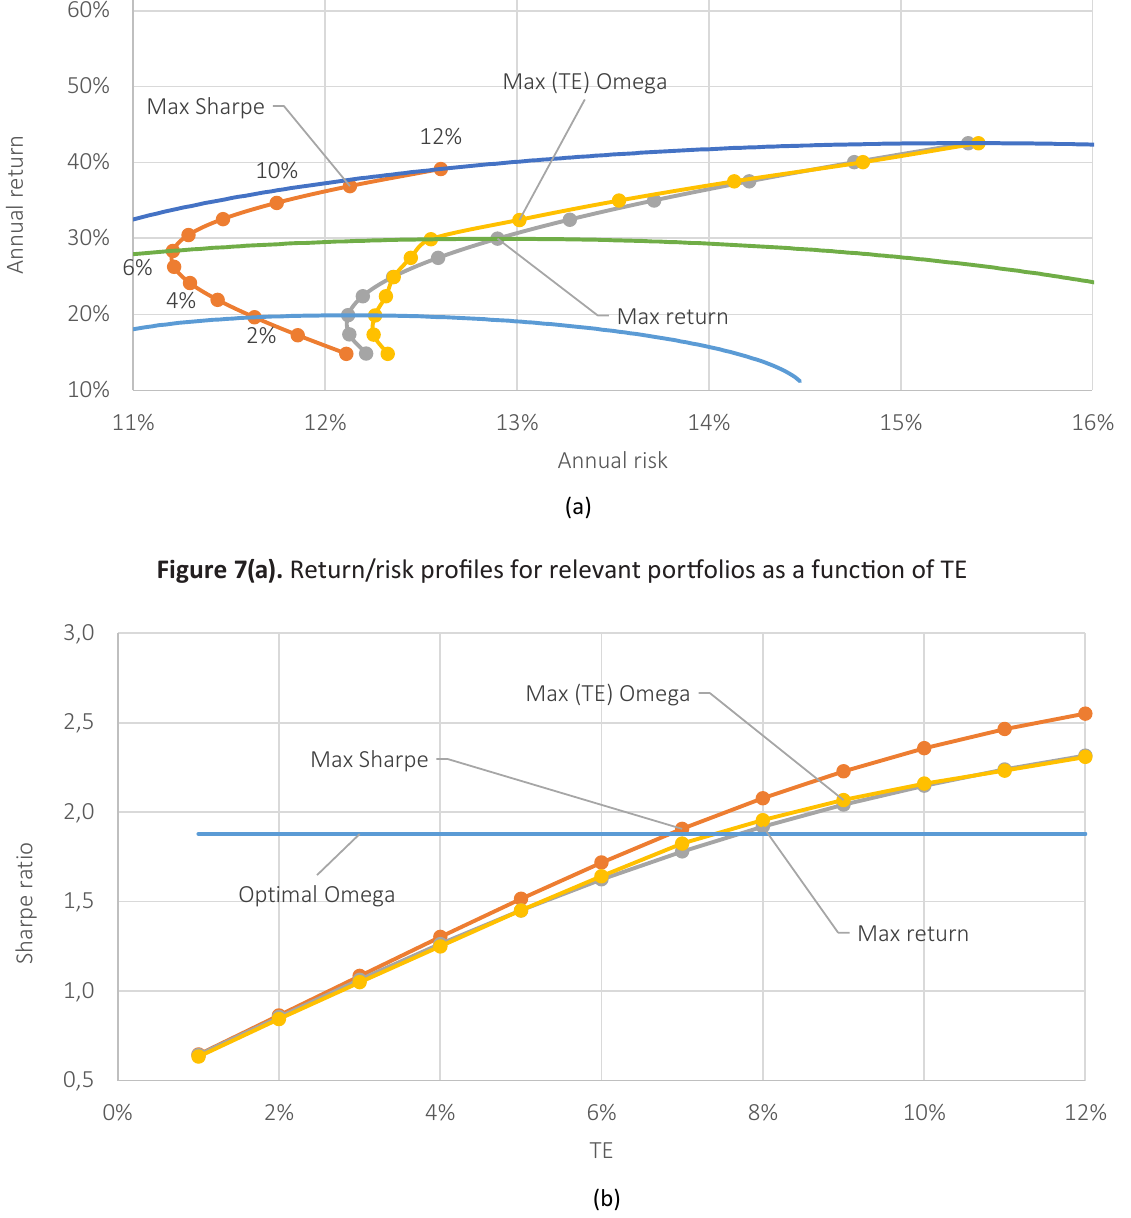
Figure 7(b). Sharpe ratios versus TE for Oct-14